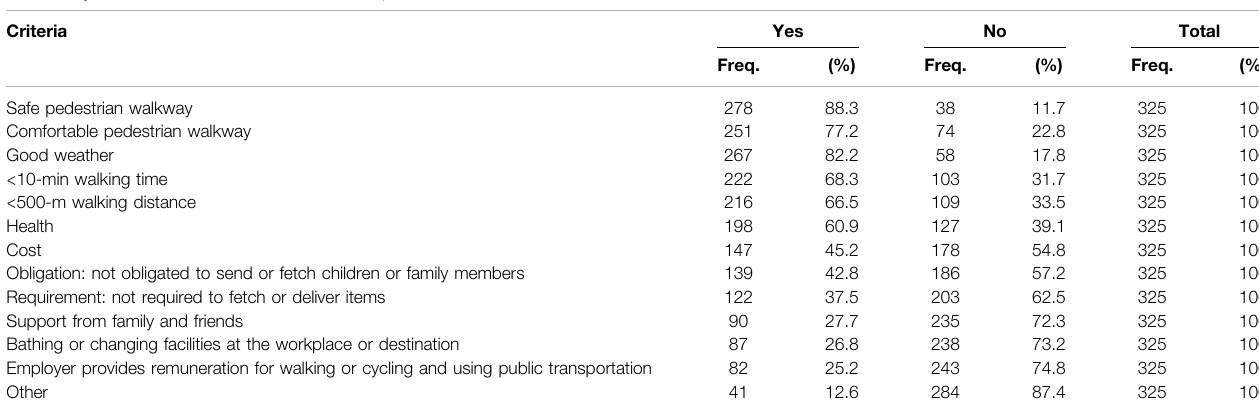
TABLE 5 | Behavior toward criteria of active